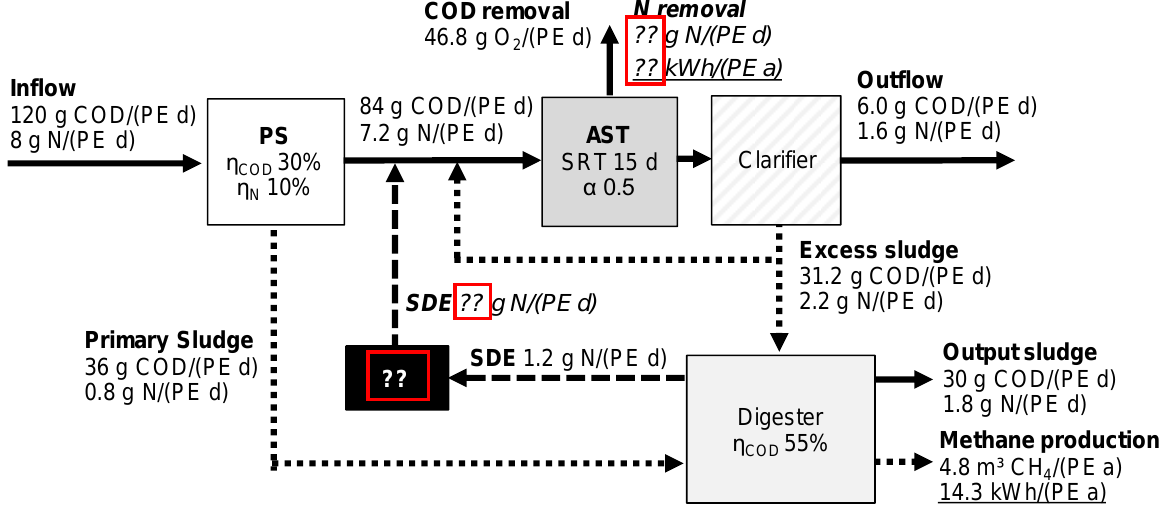
Figure 2. COD and N balances for single-stage activated sludge tanks .